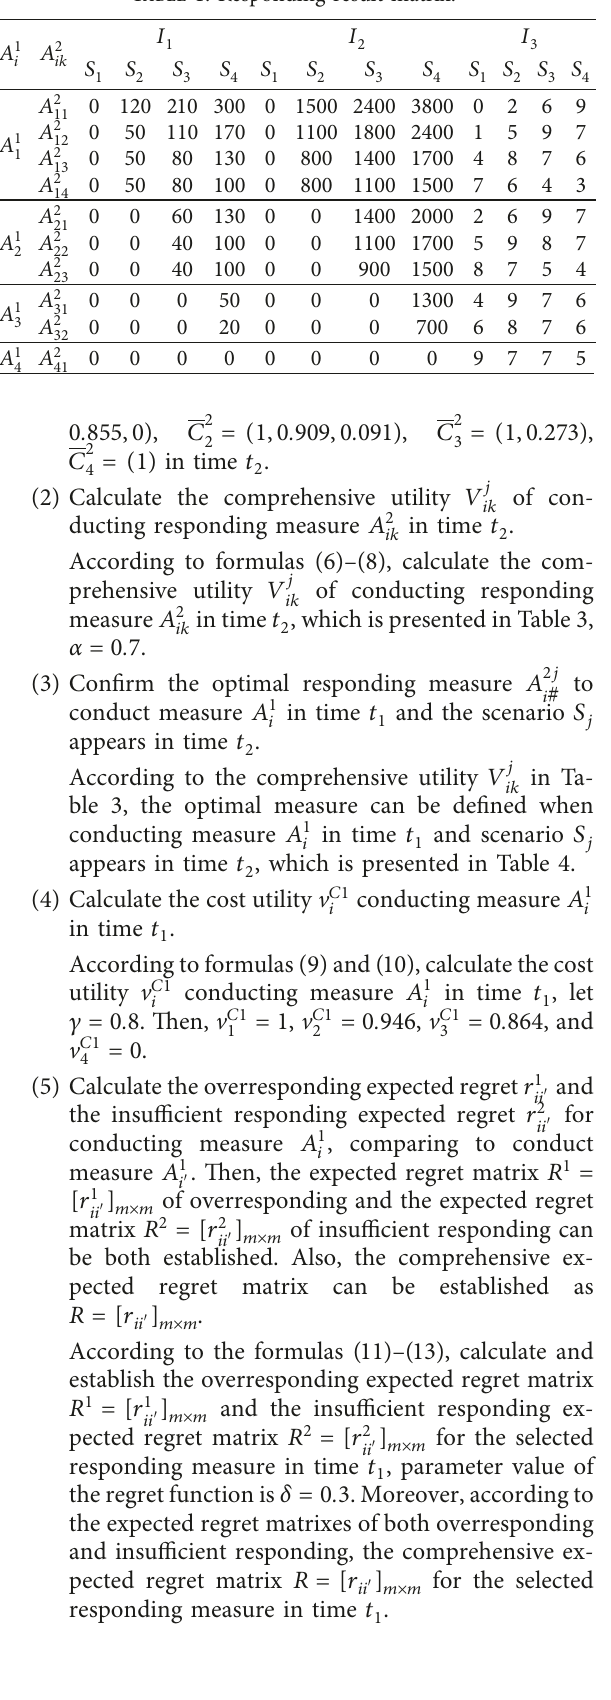
Table 1: Responding result